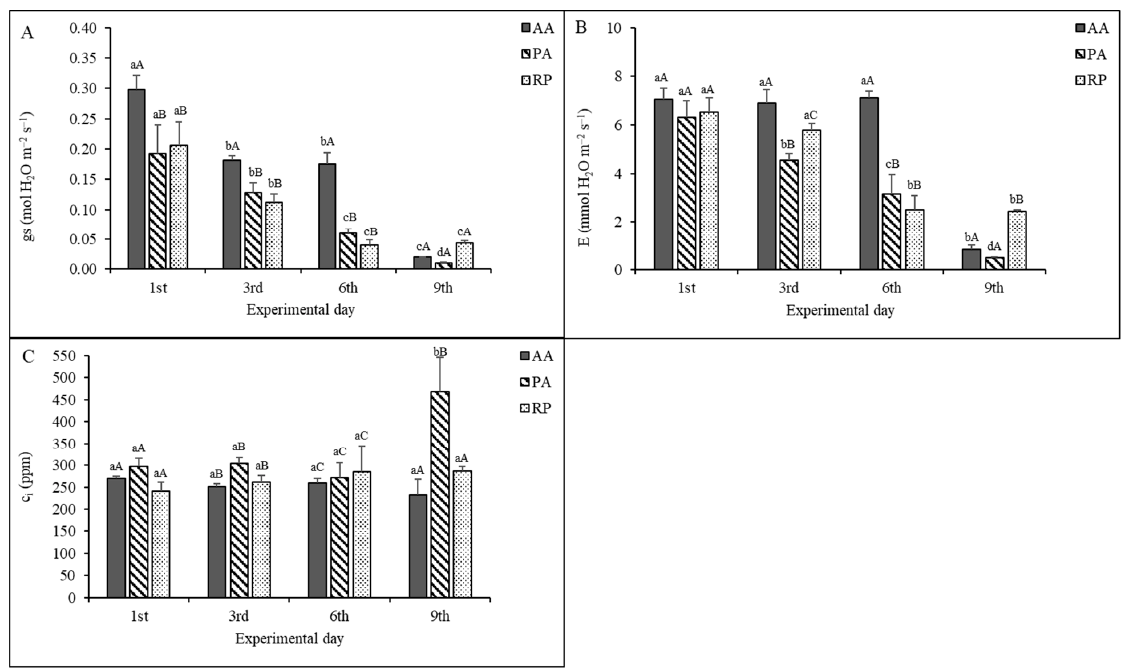
Figure A1. ( A ) Stomatal conductance (g s ), ( B ) transpiration rate (E), and ( C ) sub-stomatal CO 2 concentration (C i ) of Ailanthus altissima (AA), Phytolacca americana (PA), and Robinia pseudoacacia (RP) during the study period. Measurements carried out on the first experimental day (i.e., first) correspond to the control values. Mean ± standard deviation is shown (bars). Lowercase letters indicate differences within species, and capital letters indicate differences among species. The means with the same letters are not significantly different (two-way ANOVA, p ≤ 0.005).